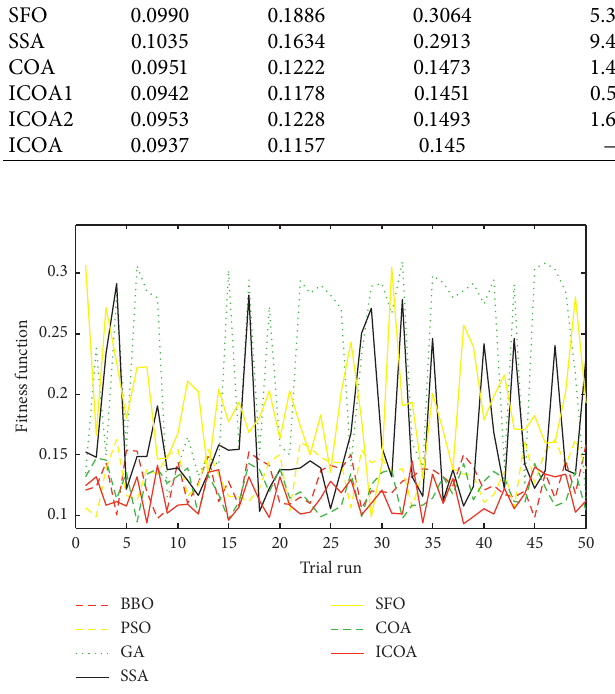
Figure 8: The fitness values of seven methods in 50 trial times for the third